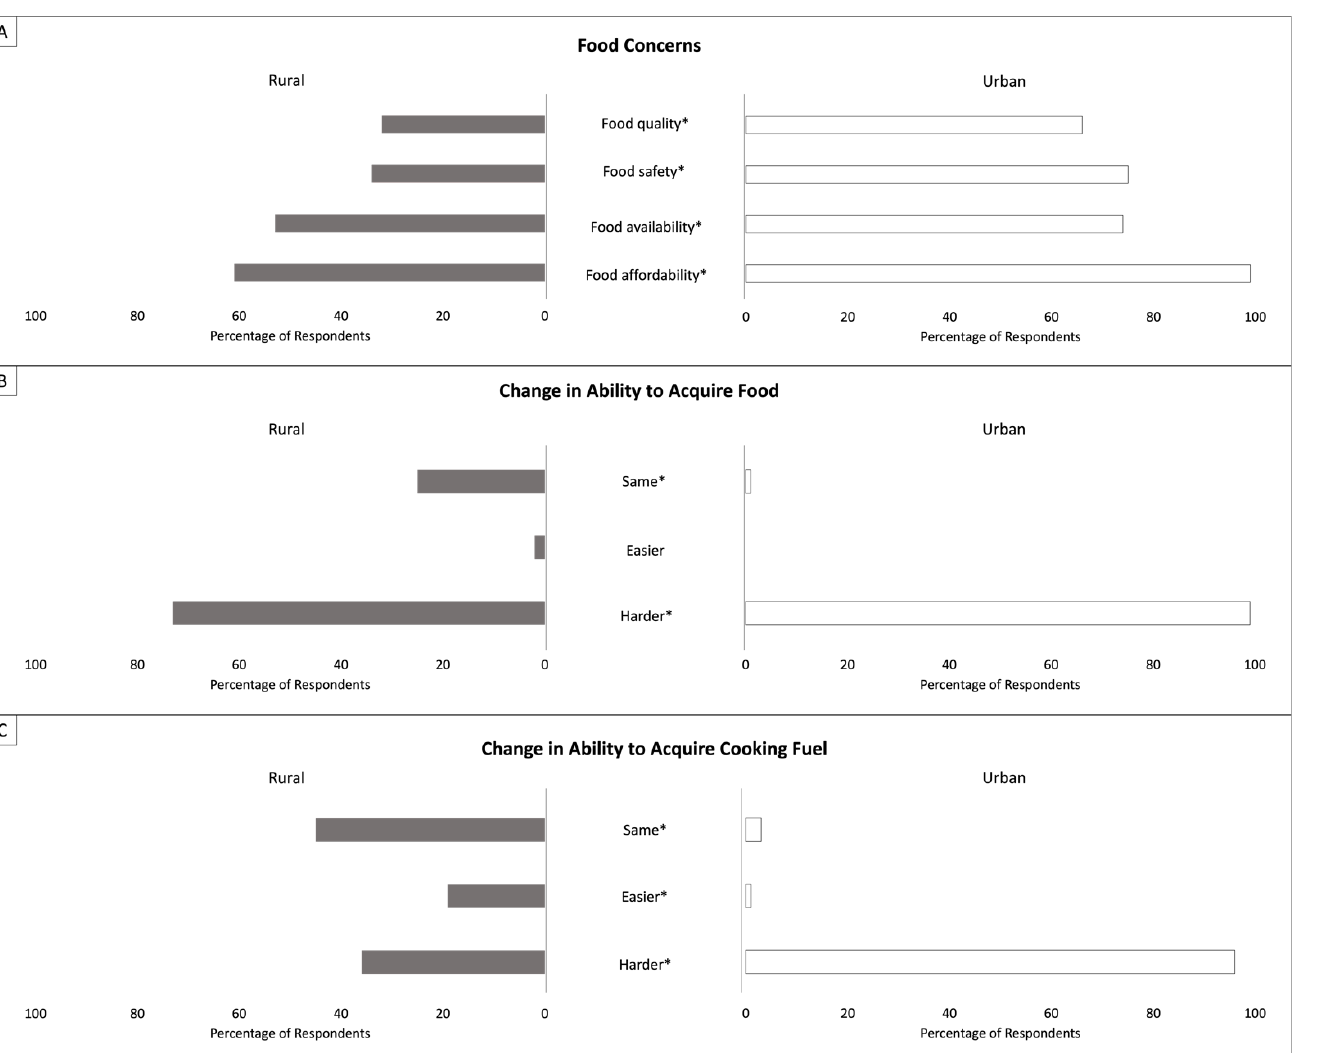
Figure 4. Influence of the COVID-19 pandemic on various components of diet in urban ( n = 144) and rural ( n = 173) Kenya. * Statistically significant at p < 0.05 ( χ 2 test). ( A ) Relative concerns of how COVID-19 pandemic may influence diet. ( B ) Reported change in ability to acquire food. ( C ) Reported ability to acquire cooking fuel. Table 3. Reported increase and decreased food accessibility, price, and consumption of select food groups in rural and urban communities in Kenya.